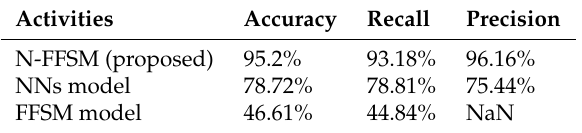
Table 5. Overall accuracy, recall, and precision obtained based on the N-FFSM, FFSM, and NN